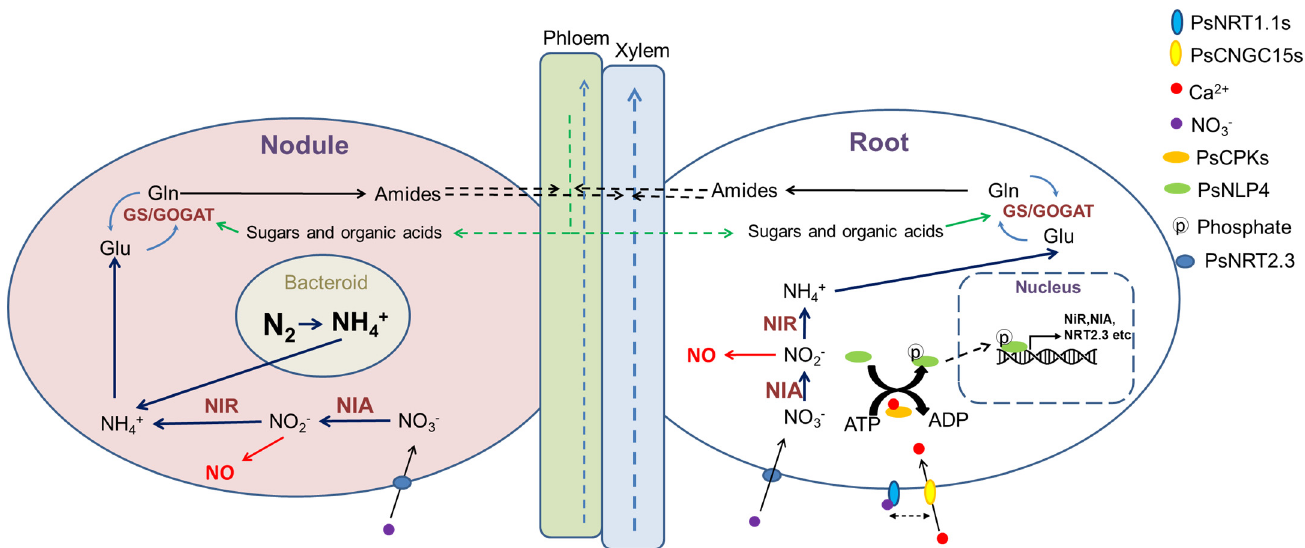
Figure 1. Diagram showing N transportation, fixation and assimilation in Pea. Figure redrawn from Murray et al., 2017 [5] Note pea is specifically an amide exporter, but other types of legume can transport organic N in the phloem as ureides and/or amino acids.